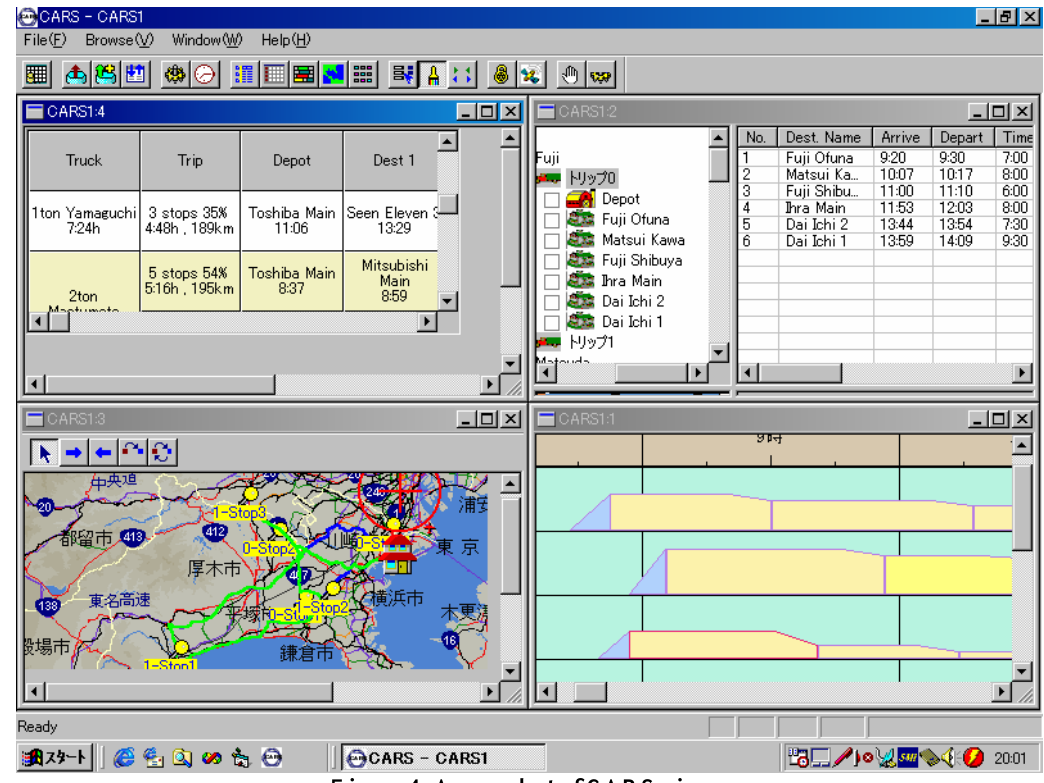
Figure 4: A snapshot of CARS